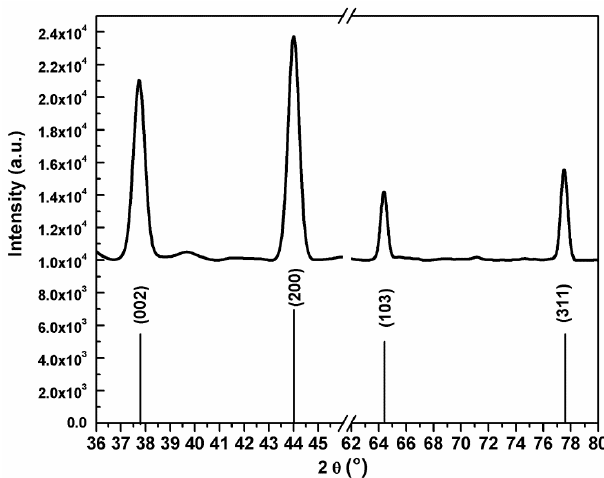
Figure 5. XRD spectrum of the AlN nanoparticles deposited on the glass substrate.